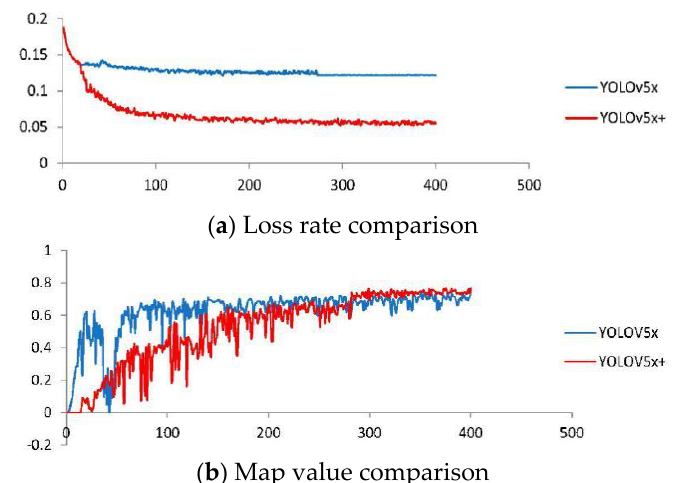
Figure 11. Comparison of test results.